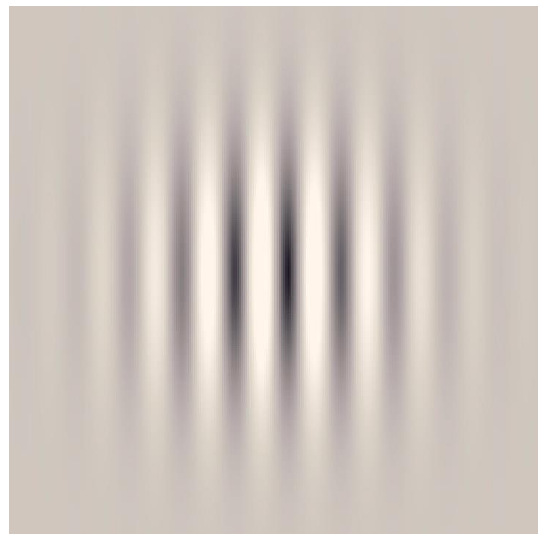
Figure 2. Gabor’s patch.